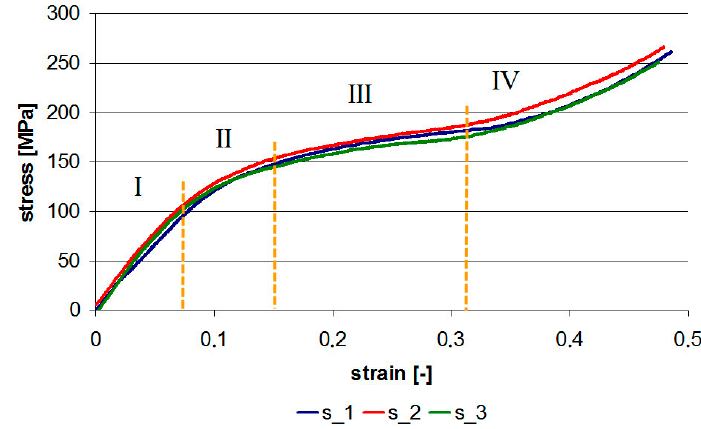
Figure 4. Stress–strain graph for static compression at constant strain rate of 4.16 × 10 − 3 1 / s.